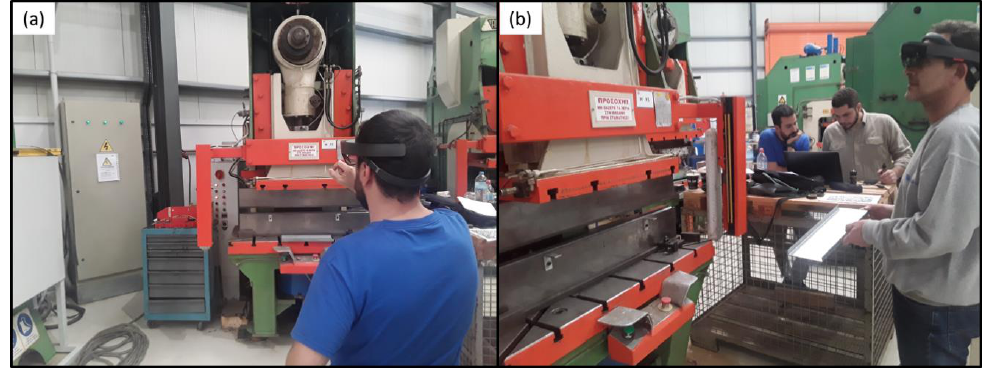
Figure 6. ( a ) Validation of the proposed framework by shop-floor technician; ( b ) Another technician tests the framework.